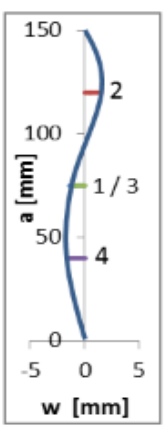
Figure 6: Side view of deformed shape of buckled laminated plate observed in the experiments.